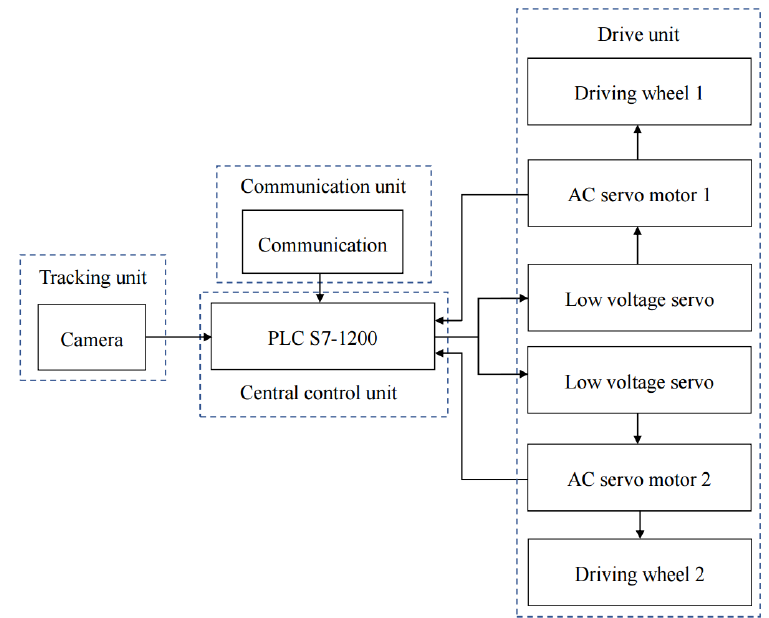
Figure 12. Block diagram of the AGV steering control system.